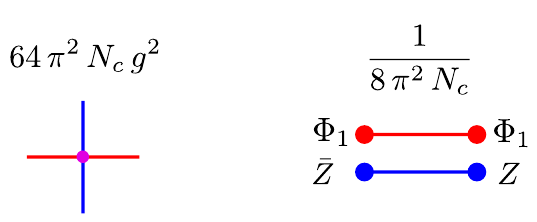
Figure 2. We only need a subset of all Feynman diagrams. Above are the conventions for the scalar propagators and the interaction vertex between Φ √ definition g = with the ‘t Hooft coupling λ = g 2 λ 4 π